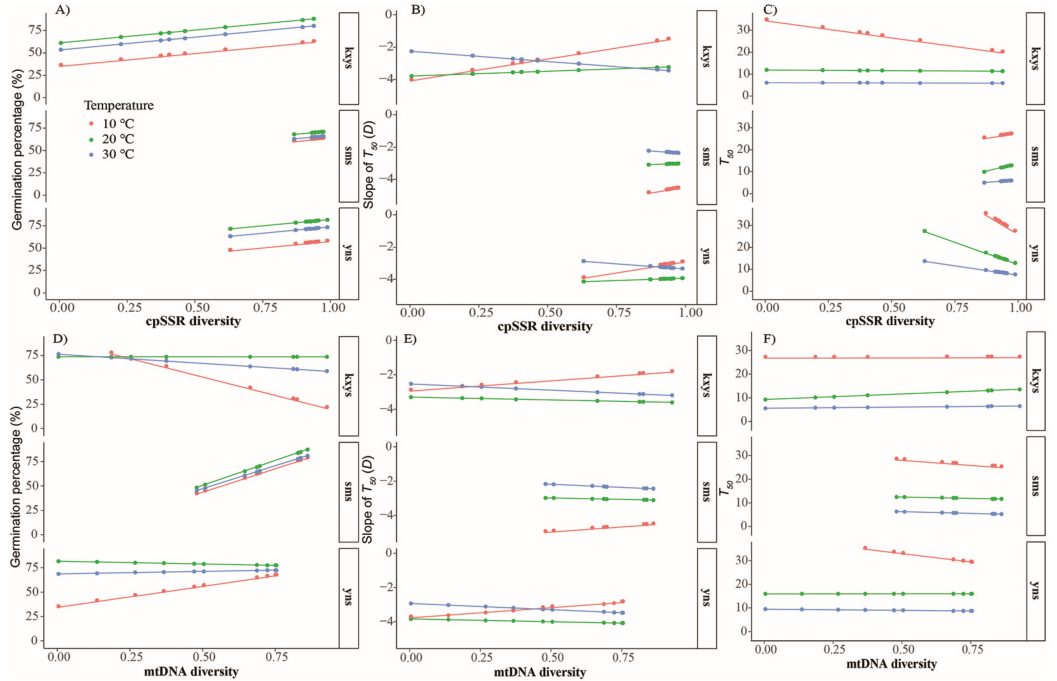
Figure 6. Relationships of germination parameters and genetic diversity of the three pine species populations at 10, 20, and 30 ◦ C. ( A – C ) show the relationships of germination percentage, slope at T 50 , and T 50 with cpDNA diversity of each species, respectively. ( D – F ) show the relationships of germination percentage, the slope at T 50 , and T 50 with mtDNA diversity of each species, respectively. kxys: Pinus kesiya ; sms: P. kesiya var. langbianensis ; yns: P. yunnanensis